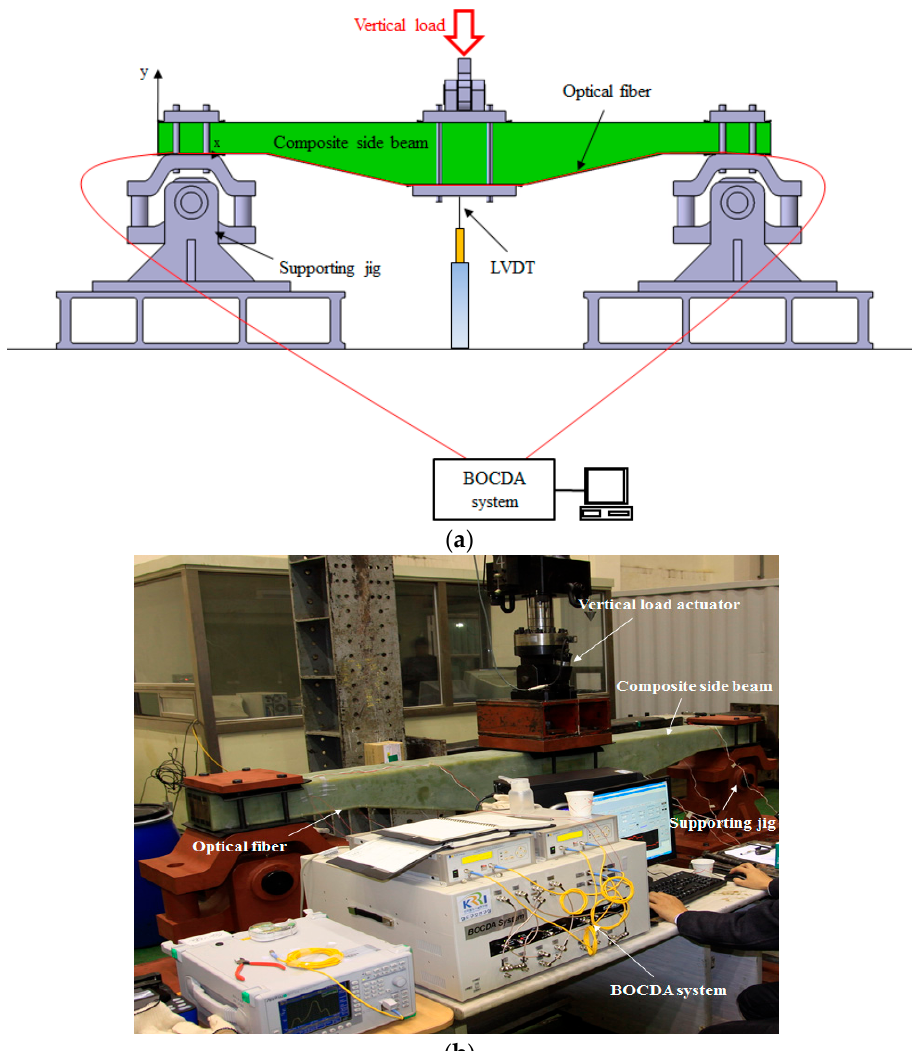
Figure 7. Setup for distributed strain monitoring test of composite side beam using an optical fiber: ( a ) setup for a vertical train load test of the composite side beam; ( b ) equipment for a vertical train load test of the composite side beam.